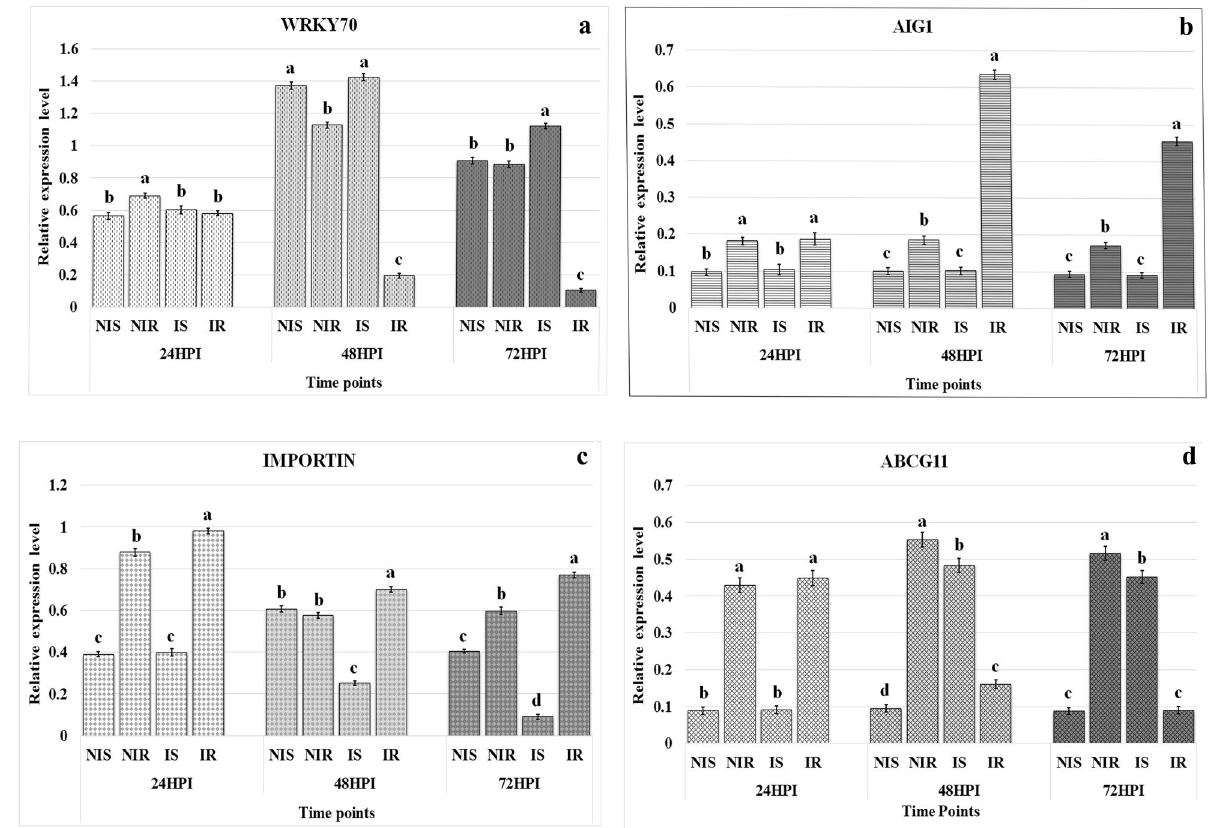
Figure 6. Relative expression levels of four TDFs in the control and Fusarium udum inoculated pigeonpea cultivars. Non-inoculated and inoculated susceptible (ICP 2376) and resistant (ICP 8863) cultivars were analyzed at three different time points by semi-quantitative reverse-transcriptase PCR. ( a ) WRKY70 WRKY transcription factor 70; ( b ) AIG1 avrRpt2 induced gene 1; ( c ) IMPORTIN importin subunit beta-1; ( d ) ABCG11 ABC transporter G family member 11. Values represent mean ± standard error from three replicates (n = 3). Letters indicate the significant differences in the means of relative expression levels for each treatment at a time point obtained using Least Significant Difference tests (p < 0.05). HPI hours post inoculation, NIS non-infected susceptible (ICP 2376), NIR non-infected resistant (ICP 8863), IS infected susceptible, IR infected Chromosomal locations of the 48 TDFs similar to pigeonpea genes were found in NCBI and LIS databases. Pathogen induced up- and down-regulated gene fragments of different functions as well as uncharacterized TDFs were present randomly in different chromosomes. Maximum number of TDFs were present on chromosomes 11 (8) and 2 (7), which were reported marker-rich in previous studies. Singh et al. 16 identified 4 wilt resistant candidate genes each of which were identified using nsSNPs. Two of these genes were found on chromosome 11 and other two on chromosome 2. Saxena et al. 11 detected 3 important QTLs and candidate genomic regions present on chromosome 11. These TDFs should be of great use in the development of genetic markers for screen- ing, identification and breeding of genotypes resistant to wilt. Functional roles as well as possible molecular interactions of pathogen-induced TDFs were predicted based on available information in previously published works and KEGG pathway database. JA/SA signaling.